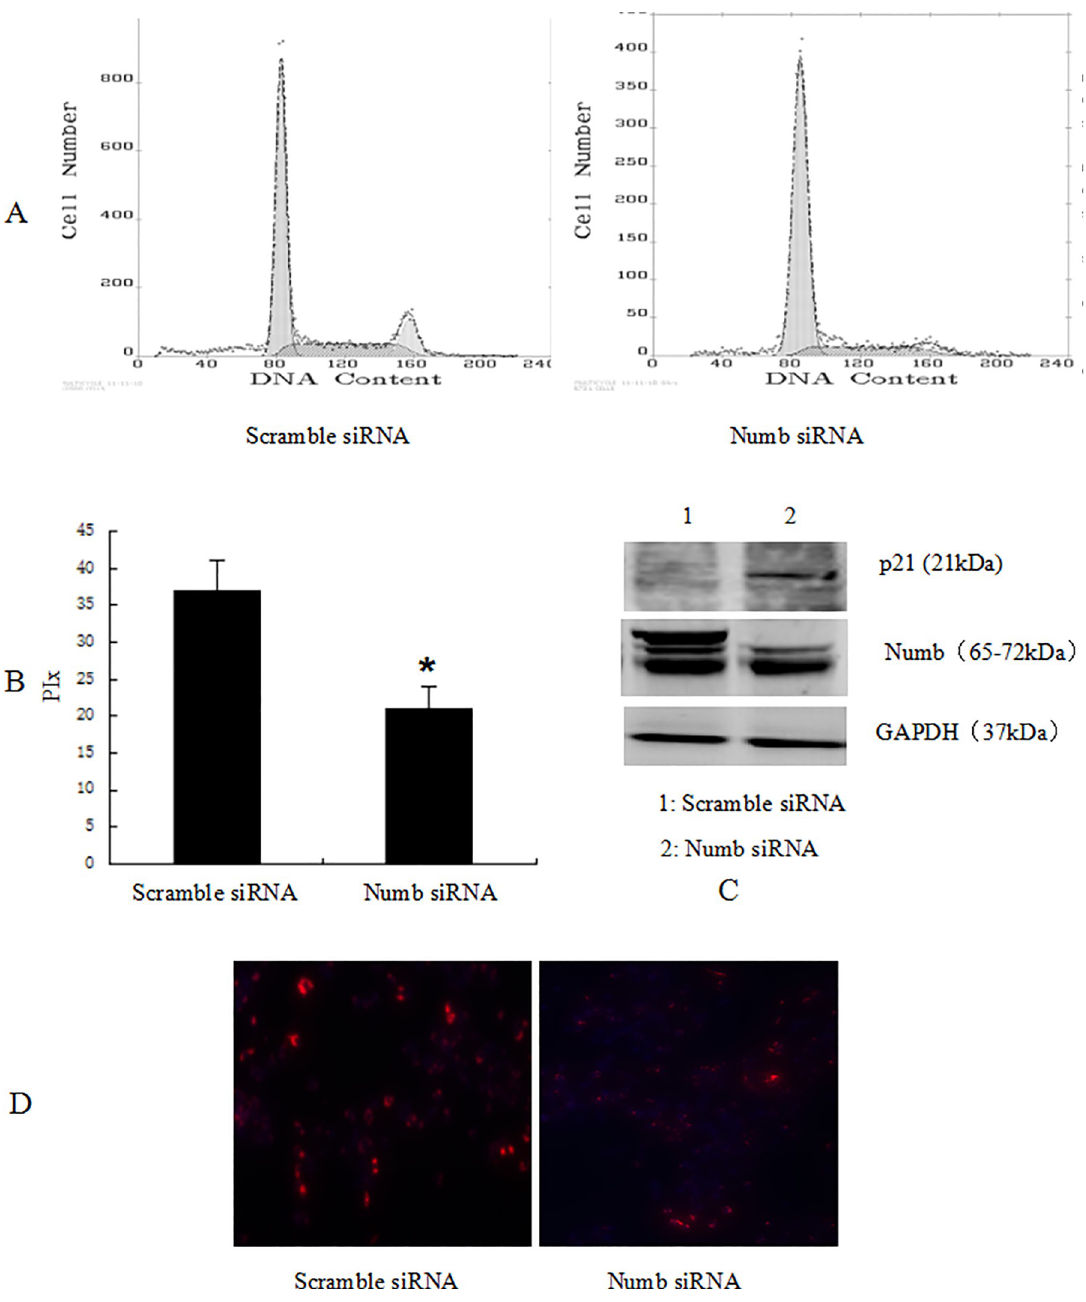
Fig 7. Knockdown of Numb up-regulated the expression of p21, inhibited BEL-7402 cell cycle progression. BEL-7402 cells were transfected with scramble siRNA, Numb siRNA, respectively. 48 h after transfection, the amount of Numb and p21 was determined by antibodies specific for Numb and p21(C). (A)Cell cycle was analysed by FACSCalibur (Becton Dickinson, Mountain View, CA). The proliferative index (PIx) decreased compared to control (P < 0.05, B) For BrdU incorporation analysis (D), the cells were incubated with a mouse monoclonal anti-BrdU antibody overnight at 4˚C, and were incubated with fluorescein isothiocyanate-conjugated goat antimouse IgG for 1 h at room temperature. Hoechst 33342 was used to label nuclei (red). Photographs were taken using a Nikon microscope. Magnification100x. The proliferation cells (red) decreased